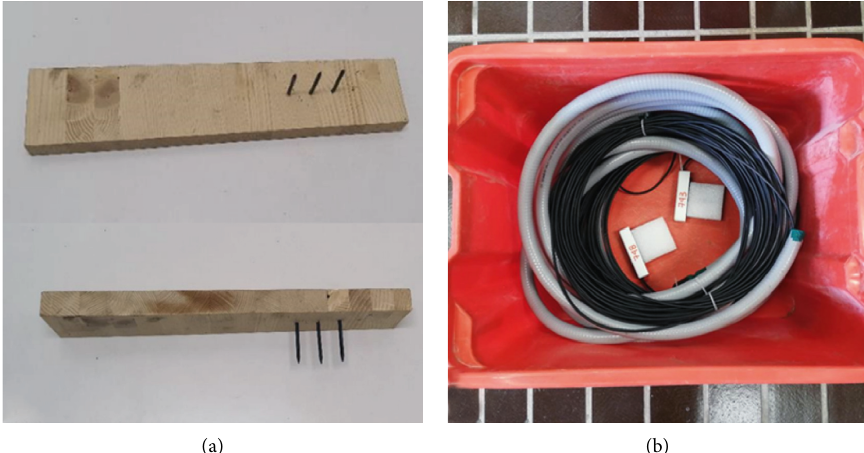
Figure 9: Preparing the sensors’ installation: (a) wooden tablets before installation; (b) cables covered with flexible metallic tubes before